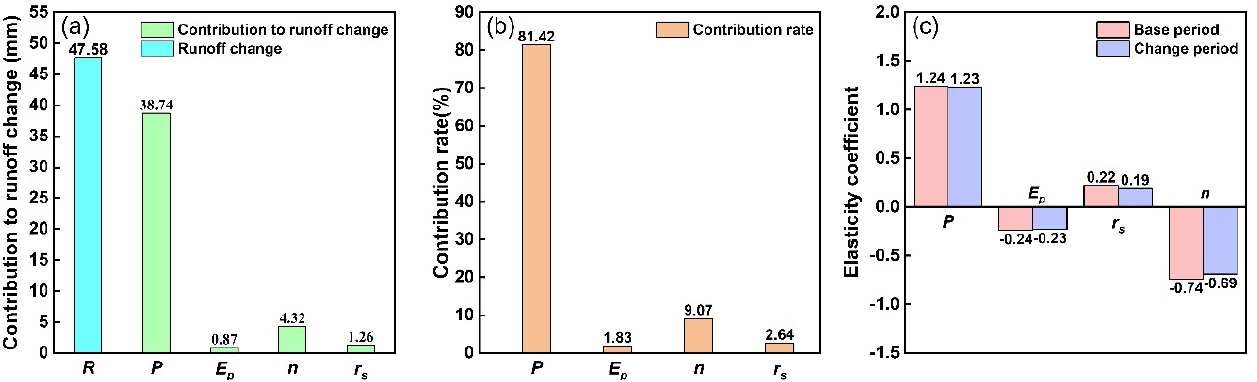
Figure 5. Contributions ( a ) and contribution rates ( b ) of change in precipitation ( P ), E P , snow ratio ( r s ), and parameter n to runoff variation and their elasticity coefficients of runoff ( c ) in the two